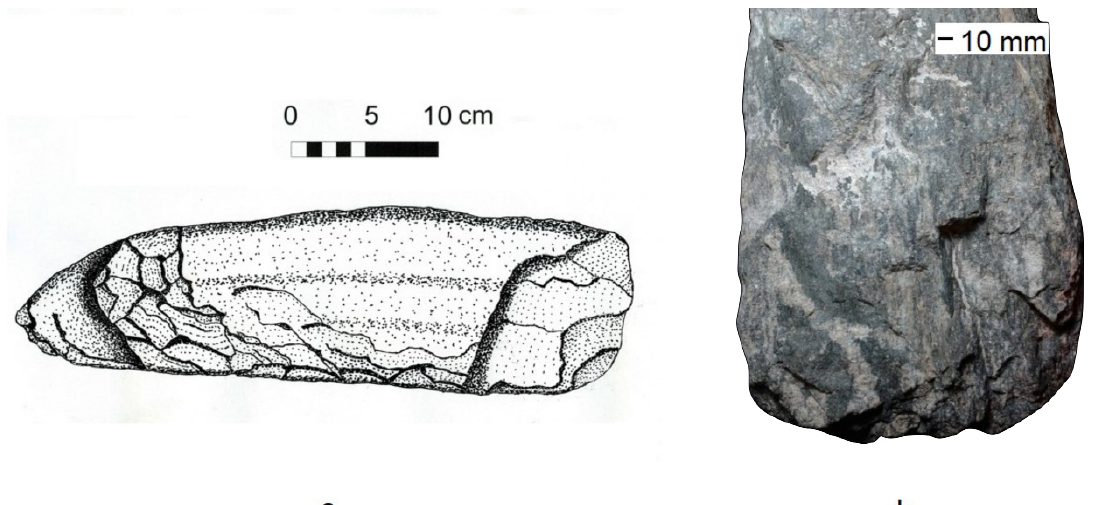
Figure 14. Specimen FN-007 #1, a pick and mattock tool made of schist. (a) Deep step-fracture scars on both ends of the obverse face of the tool. (b) Photo of broader distal working end, showing fracture scars on the reverse face. (Drawing and photograph by Steve